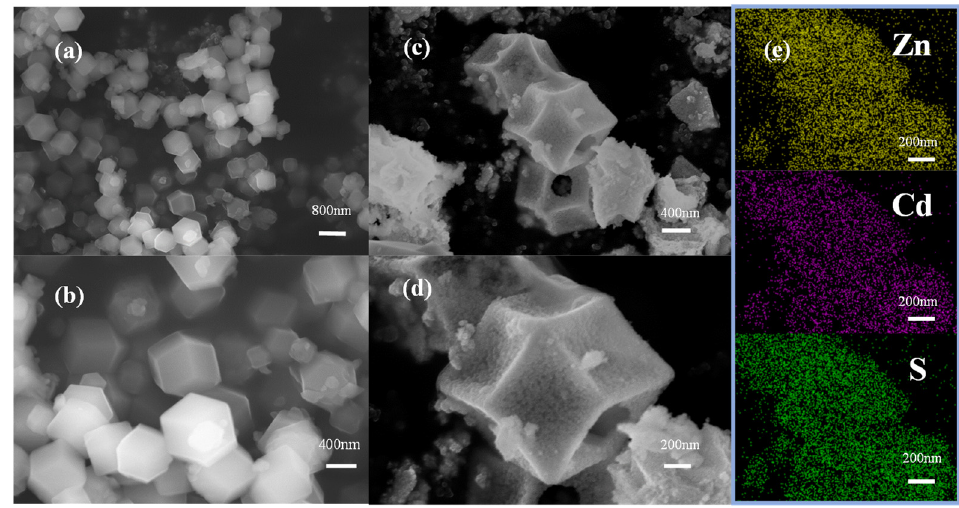
Figure 1. ( a , b ) SEM images of ZIF-8; ( c , d ) SEM images of Zn 1 − x Cd x S ; ( e ) corresponding EDS mapping of Zn 1 − x Cd x S.